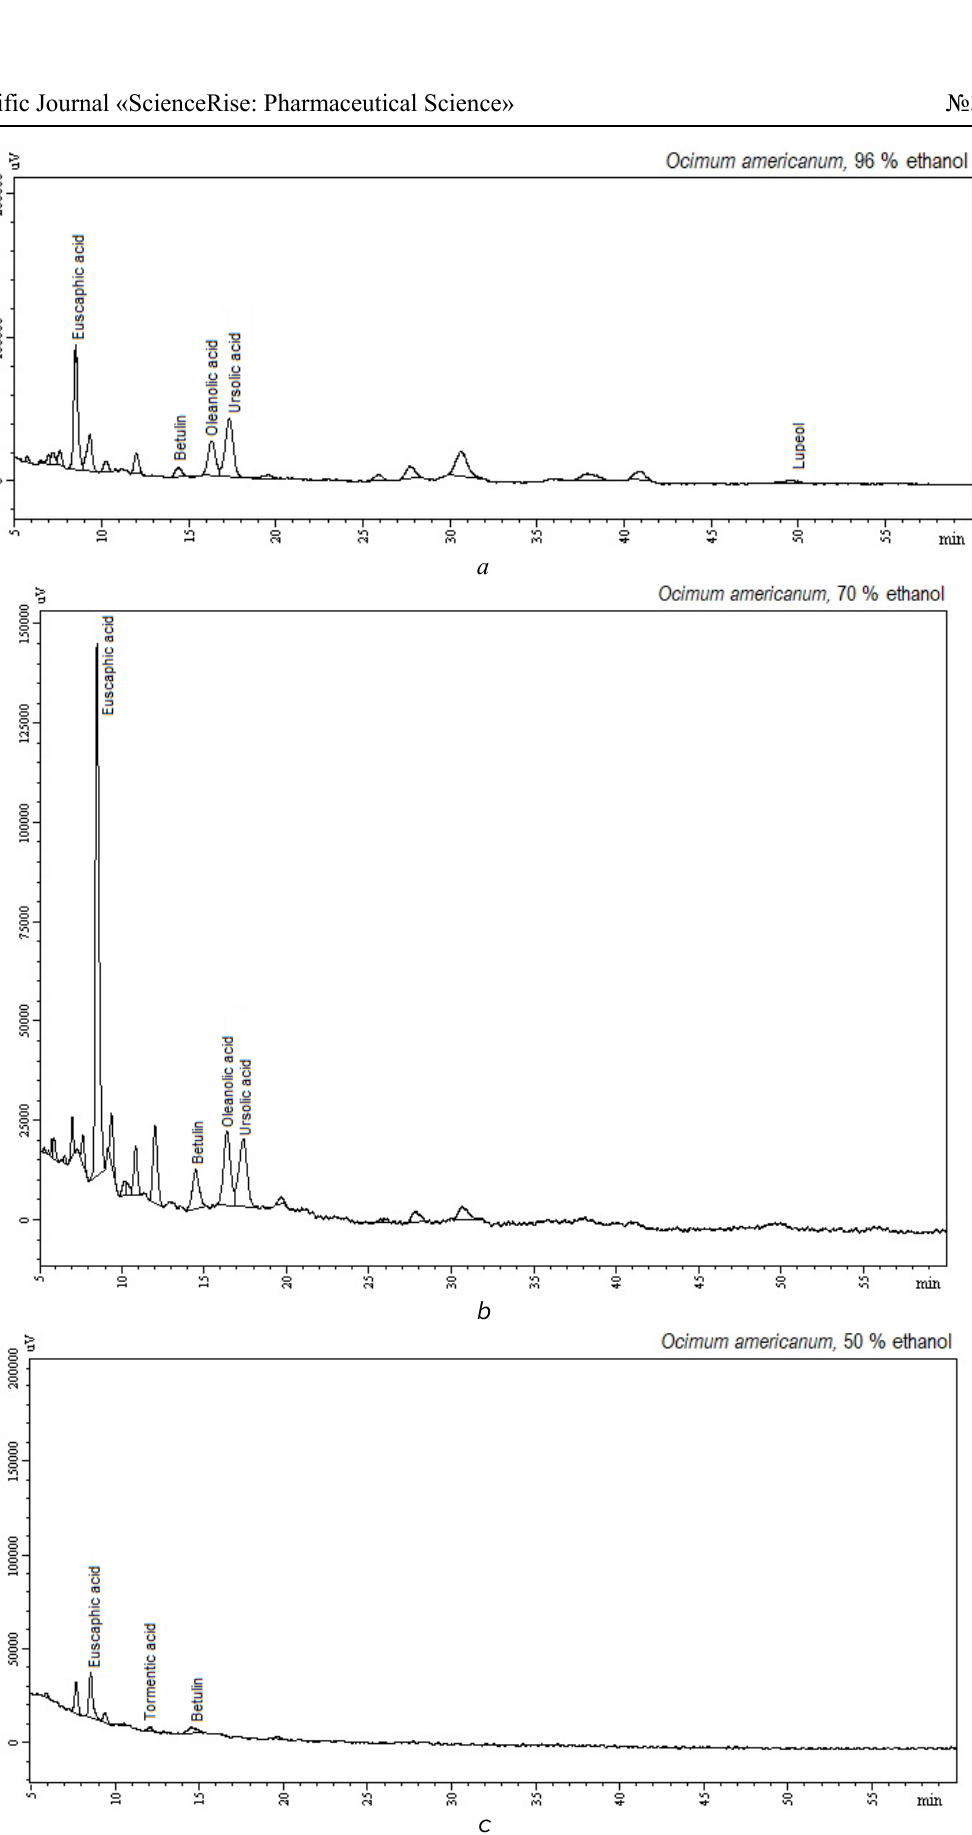
Fig. 2. Chromatogram of the O. americanum herb extracts, obtained using ethanol of various concentrations: a – 96